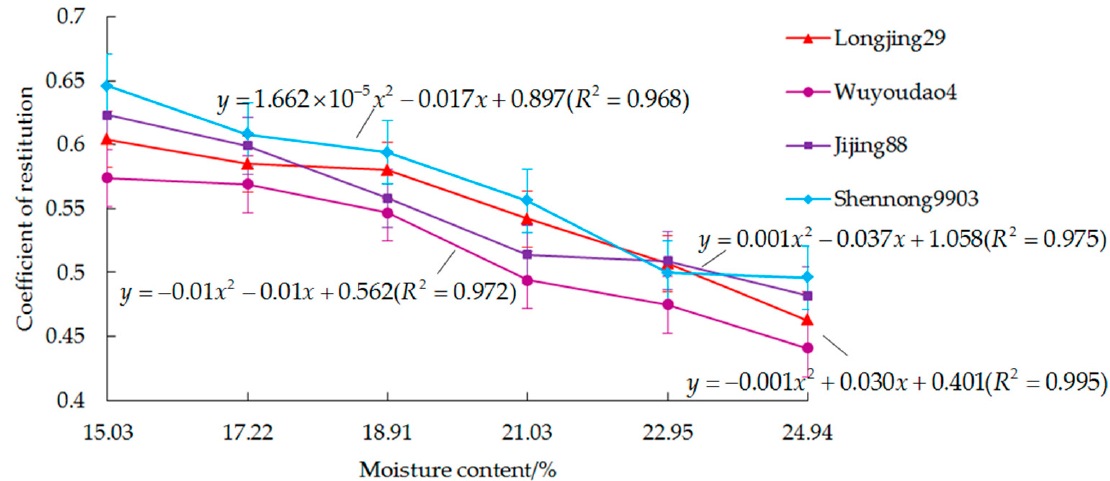
Figure 8. Effect of moisture content on restitution coefficient of rice grain. Note: In the test, the spring compression was 150 mm, and the contact material was plexiglass plate.